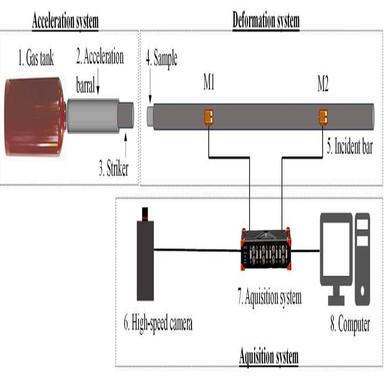
DIHB testing device and set-up.